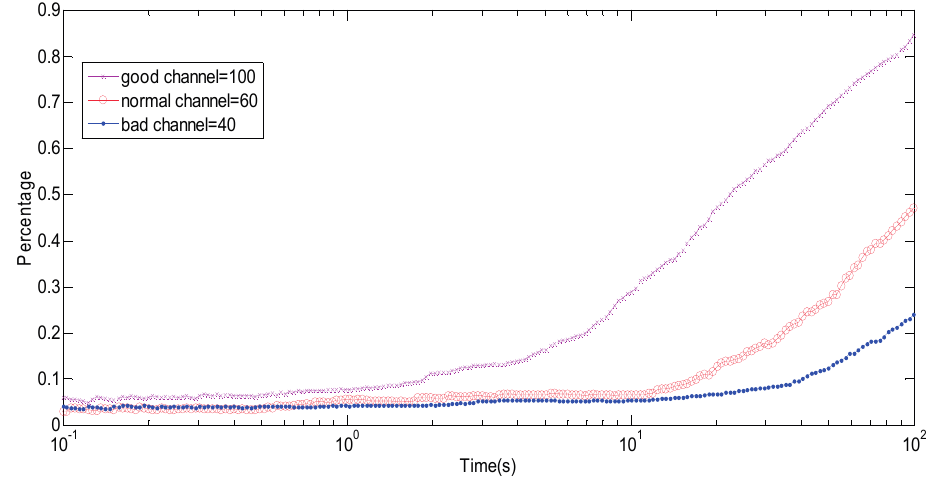
Figure 14. The optimal arm for the different wireless network